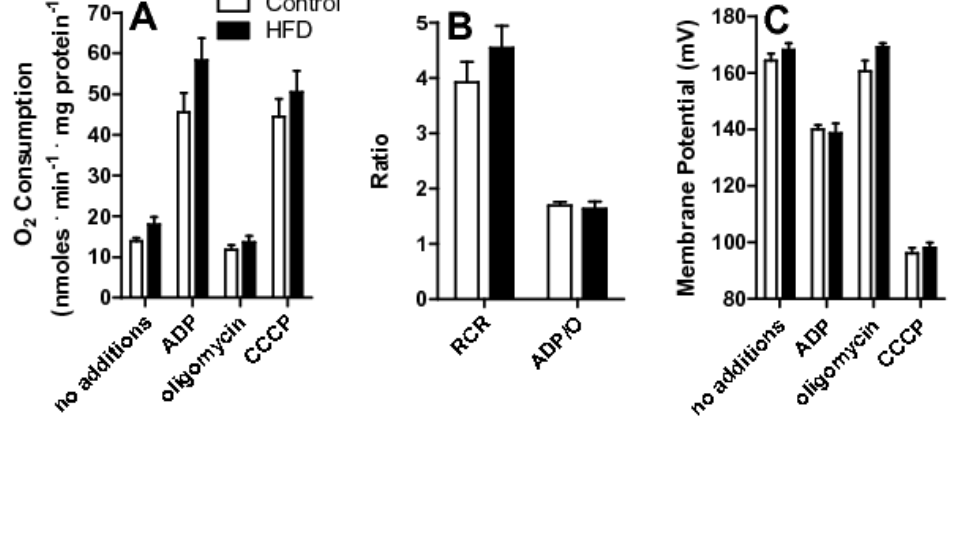
Figure 3. Mitochondrial respiration and oxidative phosphorylation are unchanged by HFD. (A) Mitochondria (0.5 mg protein. mL -1 ) were incubated in 120 mM sucrose, 65 mM KCl, 2 mM MgCl Succinate (2 mM), 1 μg/mL oligomycin, 1 mM ADP and 1 μM CCCP were added. Oxygen consumption was measured as described in Materials and Methods. (B) Respiratory control (RCR) and ADP/O ratios were calculated under the experimental conditions of Panel A. (C) Mitochondrial inner membrane potentials were measured under the conditions of Panel A, as described in Materials and Methods, n = 6 per